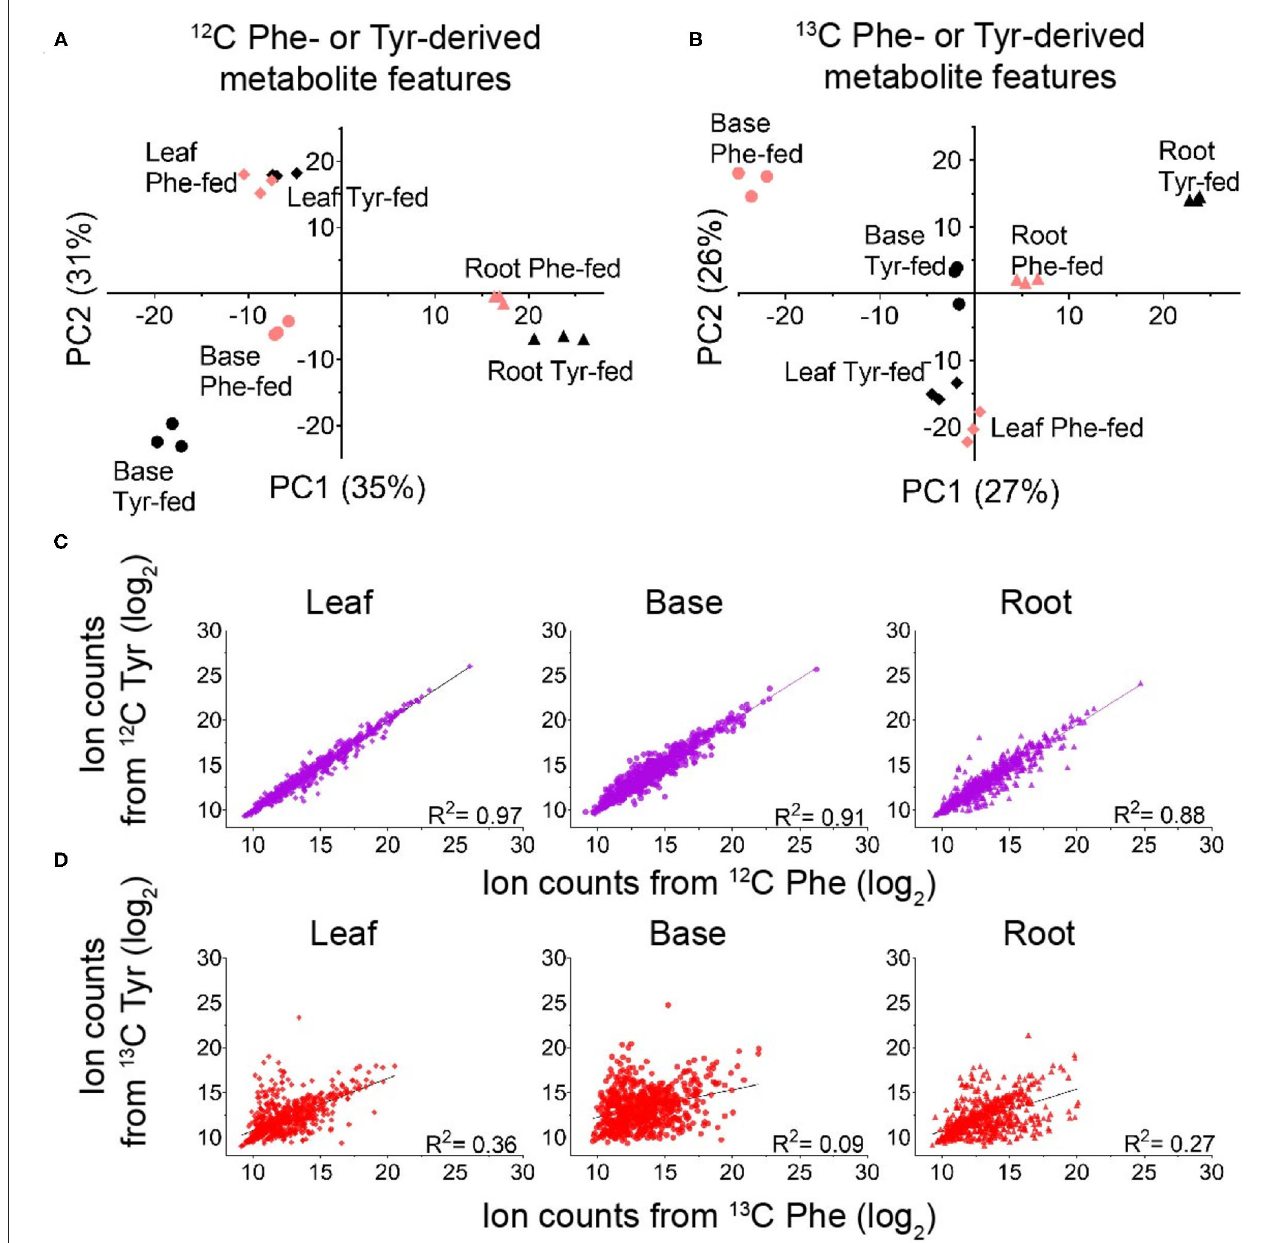
FIGURE 3 | Identifying global differences in Phe- and Tyr-derived metabolite features between labeling regimes. (A,B) Principal component analysis (PCA) score plots showing the effect of genotype on the accumulation of metabolite features derived from 12 C Phe and 12 C Tyr (A) or 13 C Phe and 13 C Tyr (B) (red, Phe-labeled; black, Tyr-labeled) ( n = 3). (C,D) Log 2 ion counts for Phe- and Tyr-derived metabolite features compared between labeling treatments. (C) Log 2 ion counts in 12 C-containing metabolite features in samples fed with 12 C Phe (x-axis) and samples fed with 12 C Tyr (y-axis). (D) Log 2 ion counts in 13 C containing metabolite features in samples fed with 13 C Phe (x-axis) and 13 C Tyr (y-axis). The broken line in each graph represents the best fit from linear regression and the correlation coefficient is reported in each graph.